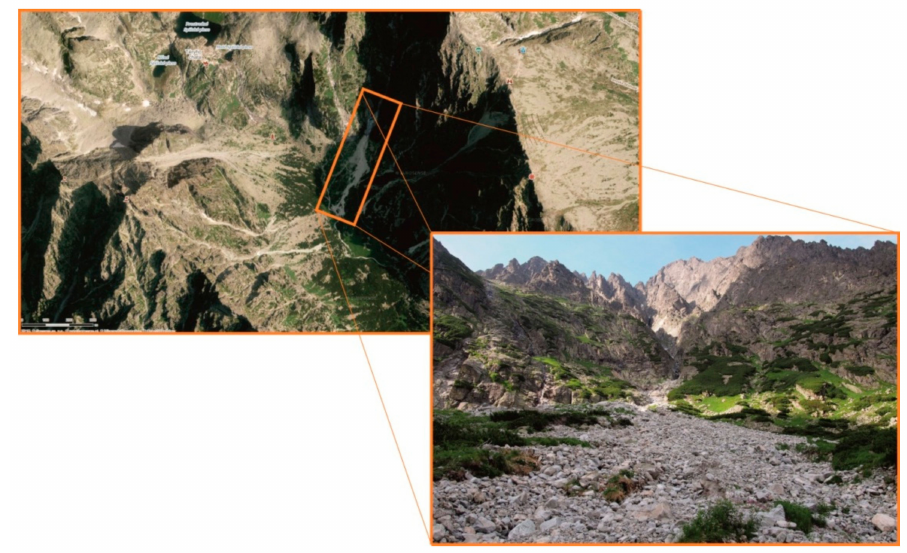
Figure 3. A documented active talus cone in the Little Cold Valley, High Tatras, Slovakia.